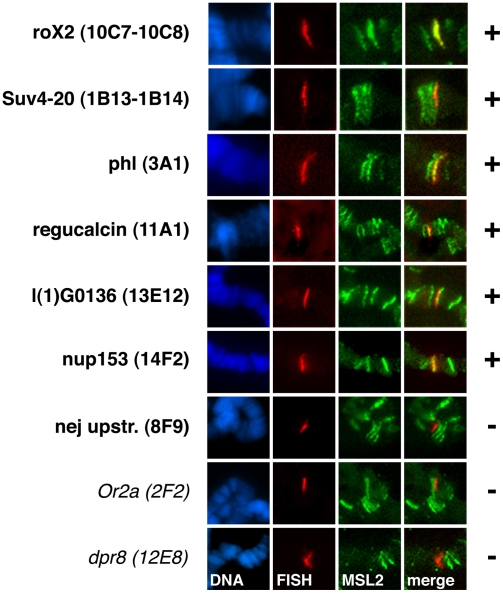
High-affinity sites in SL2 cells frequently map to MSL2 signals in Sxb1-2C females by Immuno-FISH on polytene chromosomes.Each row corresponds to one locus and is labeled with the name of the closest gene and the cytological position. (+) on the right indicates that FISH probe signal and MSL2 colocalized robustly; in the case of (−) no colocalization could be observed. No colocalization is expected with the control FISH probes Or2a and dpr8.